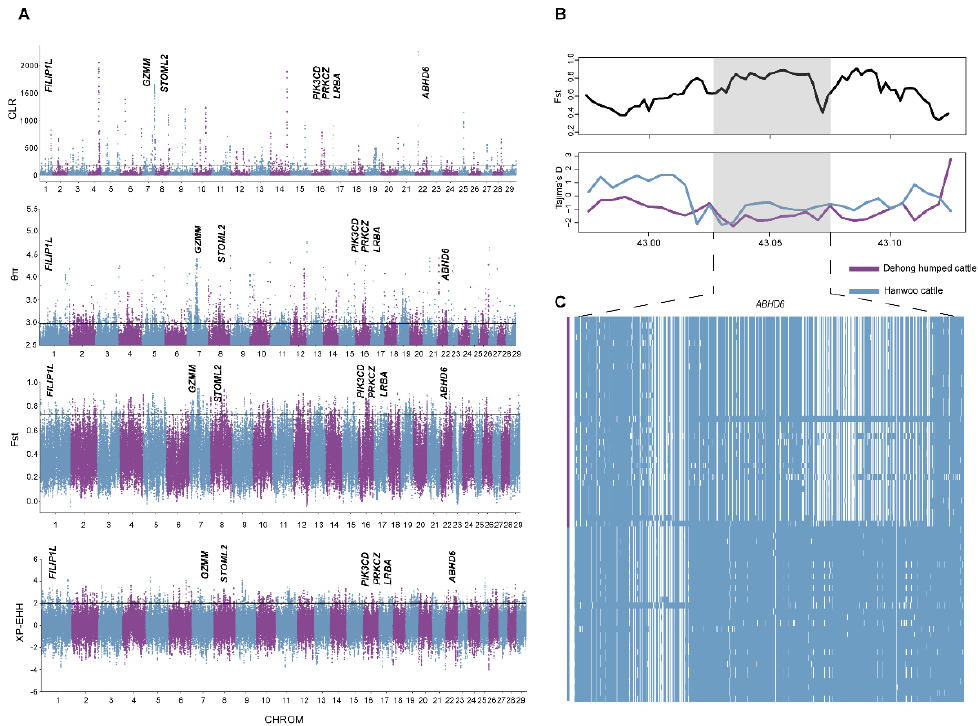
Figure 4. The signatures of the positive selection in Dehong humped cattle. ( A ) Manhattan plot of selective sweeps by θπ , CLR, F ST , and XP-EHH. ( B ) F ST and Tajima’s D plots of the ABHD6 gene. ( C ) Haplotype diversity of the ABHD6 gene.